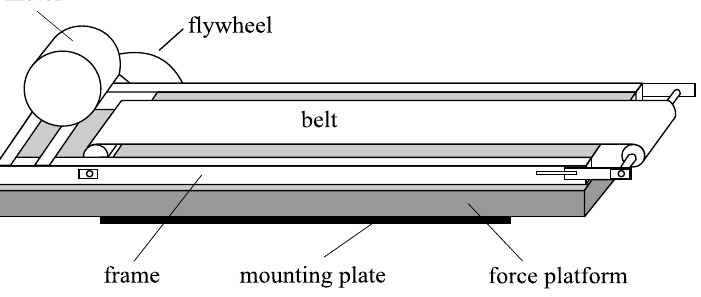
Fig. 7. Example of single-belt treadmill design (after Kram et al. [18]).